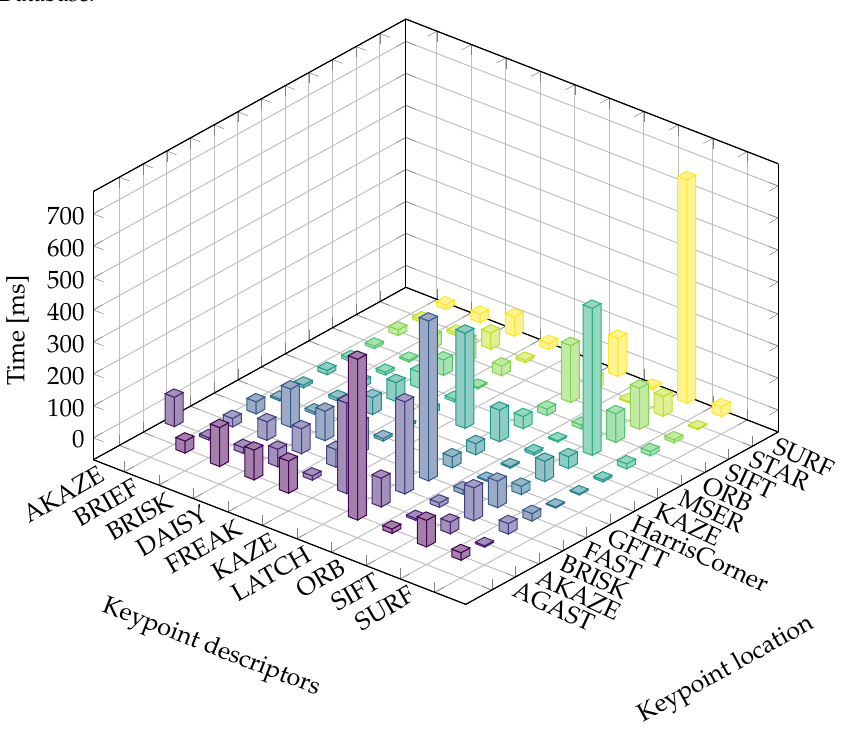
Figure 7. Time taken to calculate the descriptors for all keypoints in the Oxford University Database.